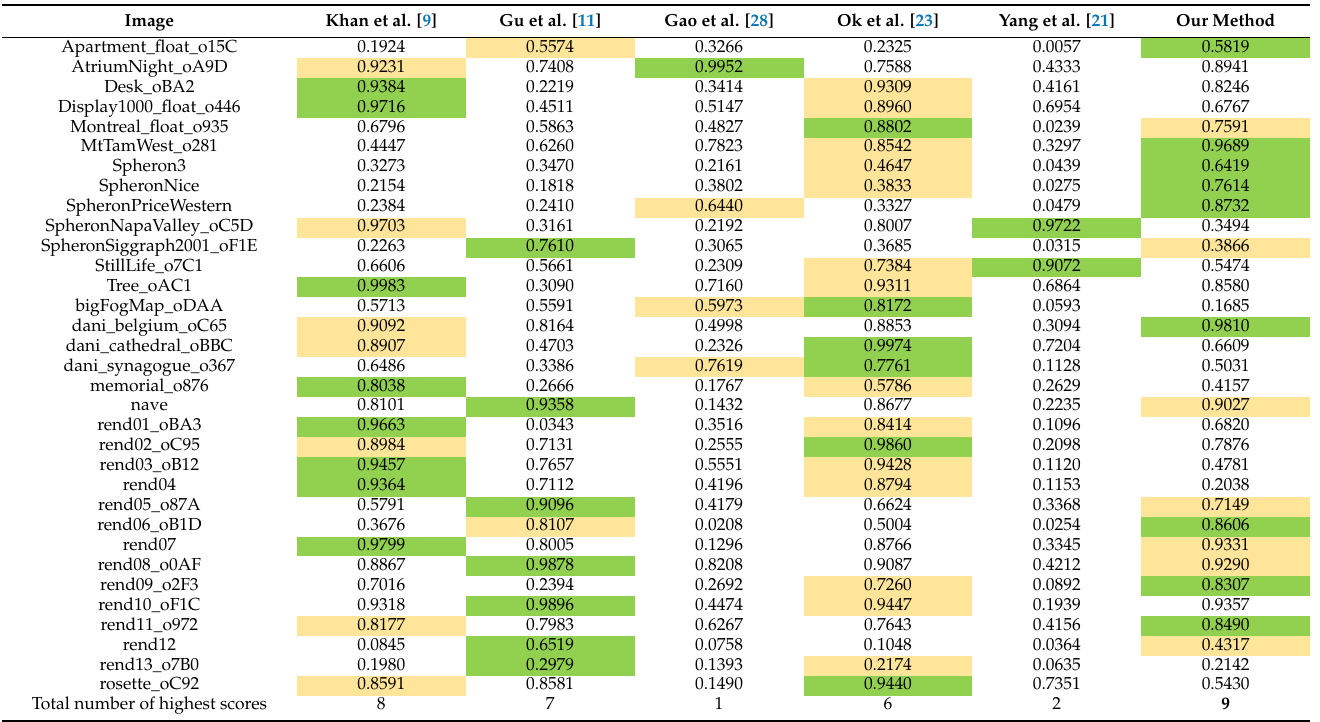
Table 3. TMQI-N score of images from the dataset in [29] and total number of highest scores for each method.